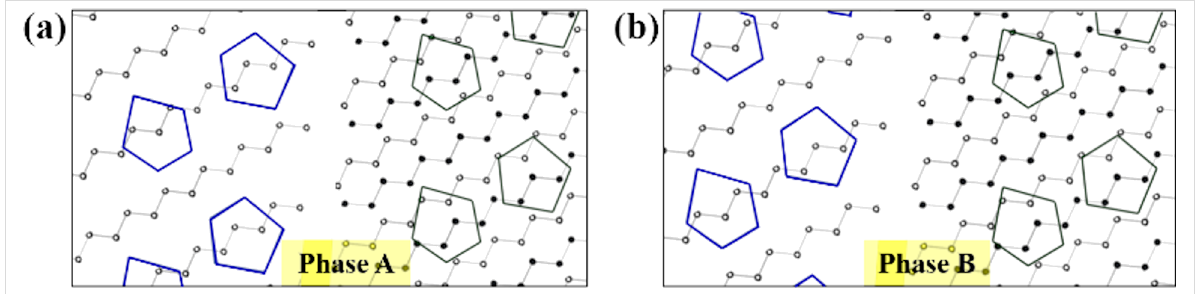
Figure 5: Models of phase relationships between pentagons on the upper terrace (green) and those on the lower terrace (blue) with atom 1 and 2 (defined in Figure 4) being removed. The first layer and second layer Si rows are indicated by black and white circles, respectively. (a) Phase A shows an actual phase relationship of the 16×2 reconstruction. (b) In phase B, pentagon pairs on the lower terrace are shifted by a half cycle (16×1) along the zig-zag